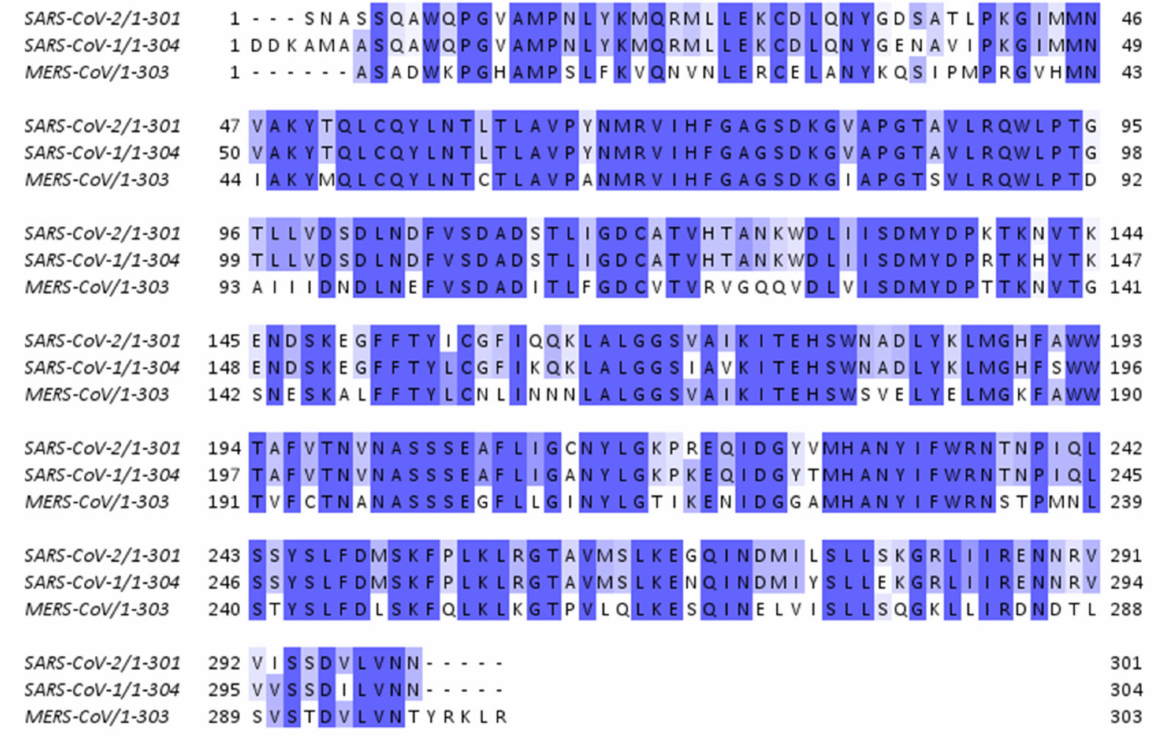
Figure 1. Sequence alignments of nsp16 for SARS-CoV-2, SARS-CoV-1, and MERS-CoV. The dark blue colour indicates that residues show >80% identity with the consensus residues. Blue colour indicates >60%, the light blue colour indicates >40%, and the white colour indicates <40%